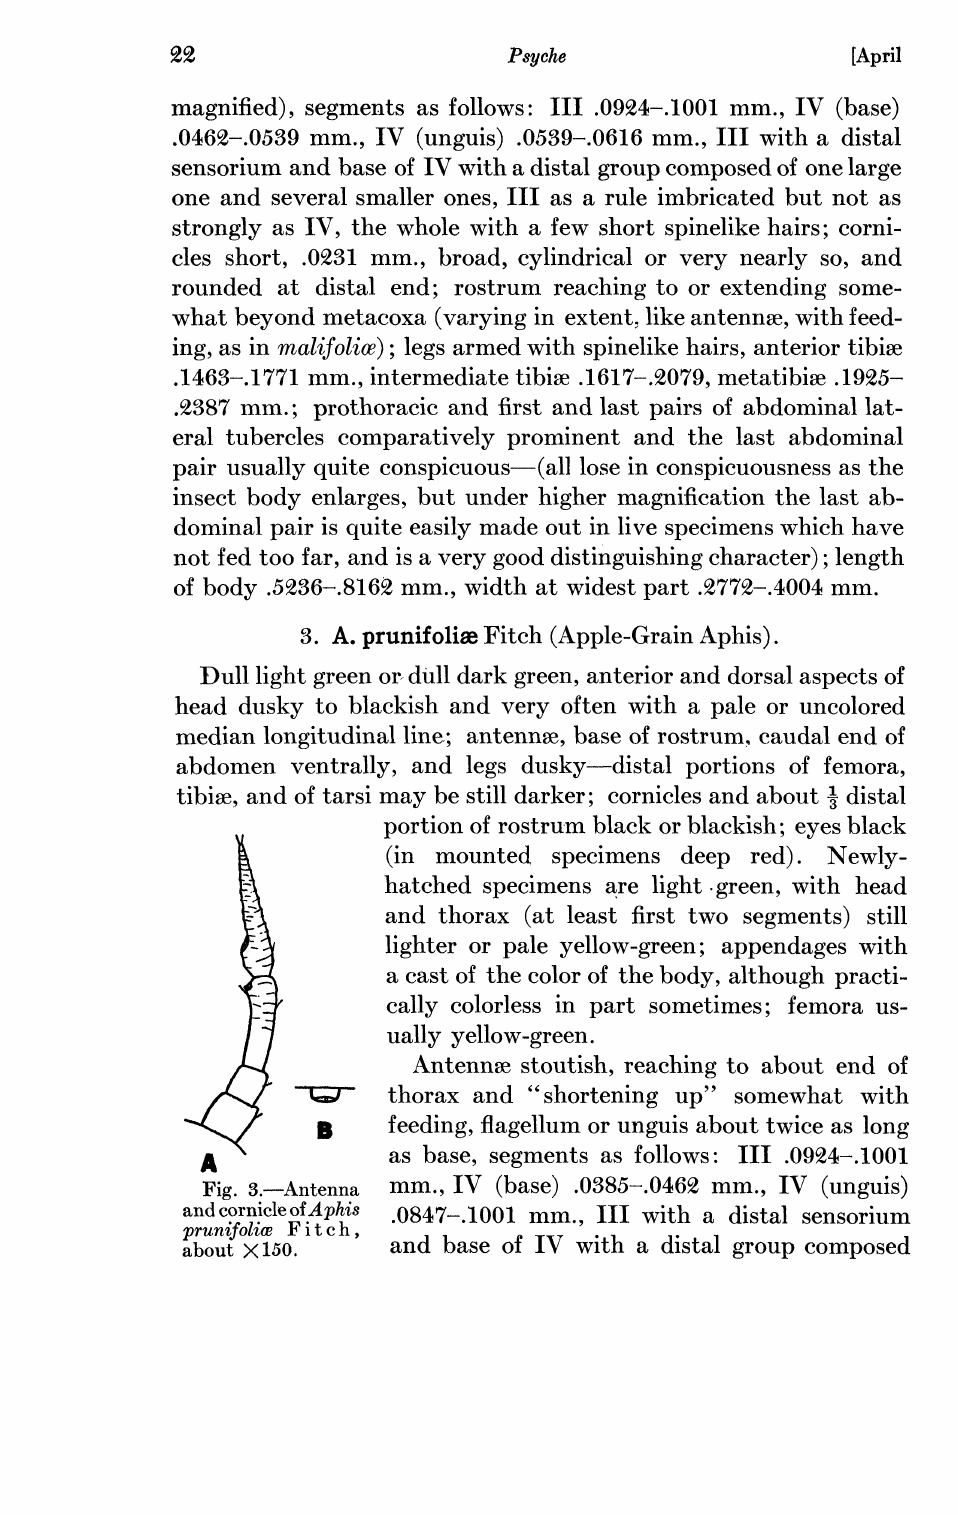
Fig. 8.--Antenna and cornicle of Aphis prunifolice F t c h, about >(